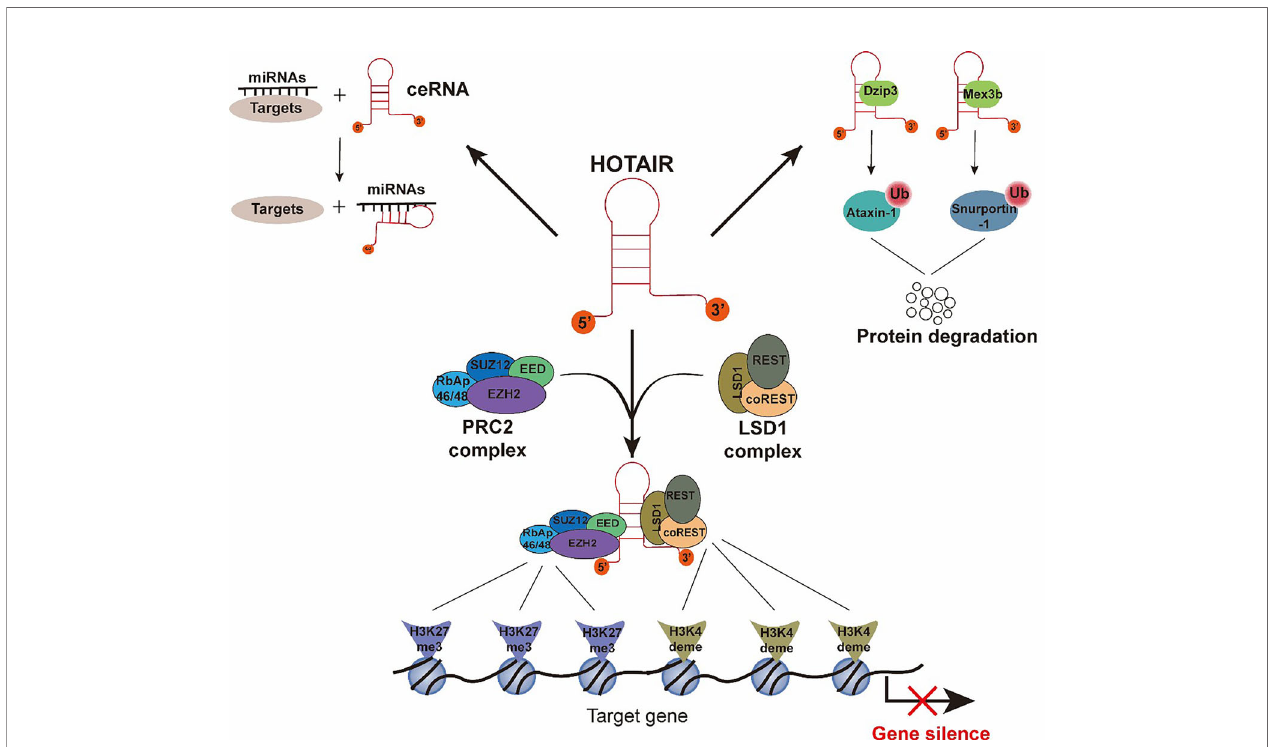
FIGURE 2 | Functions and molecular mechanisms of HOTAIR. The interactions between HOTAIR and its several important partners are summarized. (1) The 5 ′ -end of HOTAIR binds to the PRC2 complex. The 3 ′ -end of HOTAIR binds to the LSD1 complex. H3K27 tri-methylation and H3K4me3 demethylation result from PRC2 complex and LSD1 complex activity, respectively, and cause gene silencing. (2) HOTAIR interacts with E3 ubiquitin ligases, Dzip3 and Mex3b, and facilitates the ubiquitination of Ataxin-1 and Snurportin-1, thereby contributing to their degradation. (3) HOTAIR interacts with miRNAs as a competitive endogenous RNA to promote the expression of miRNA-targeted